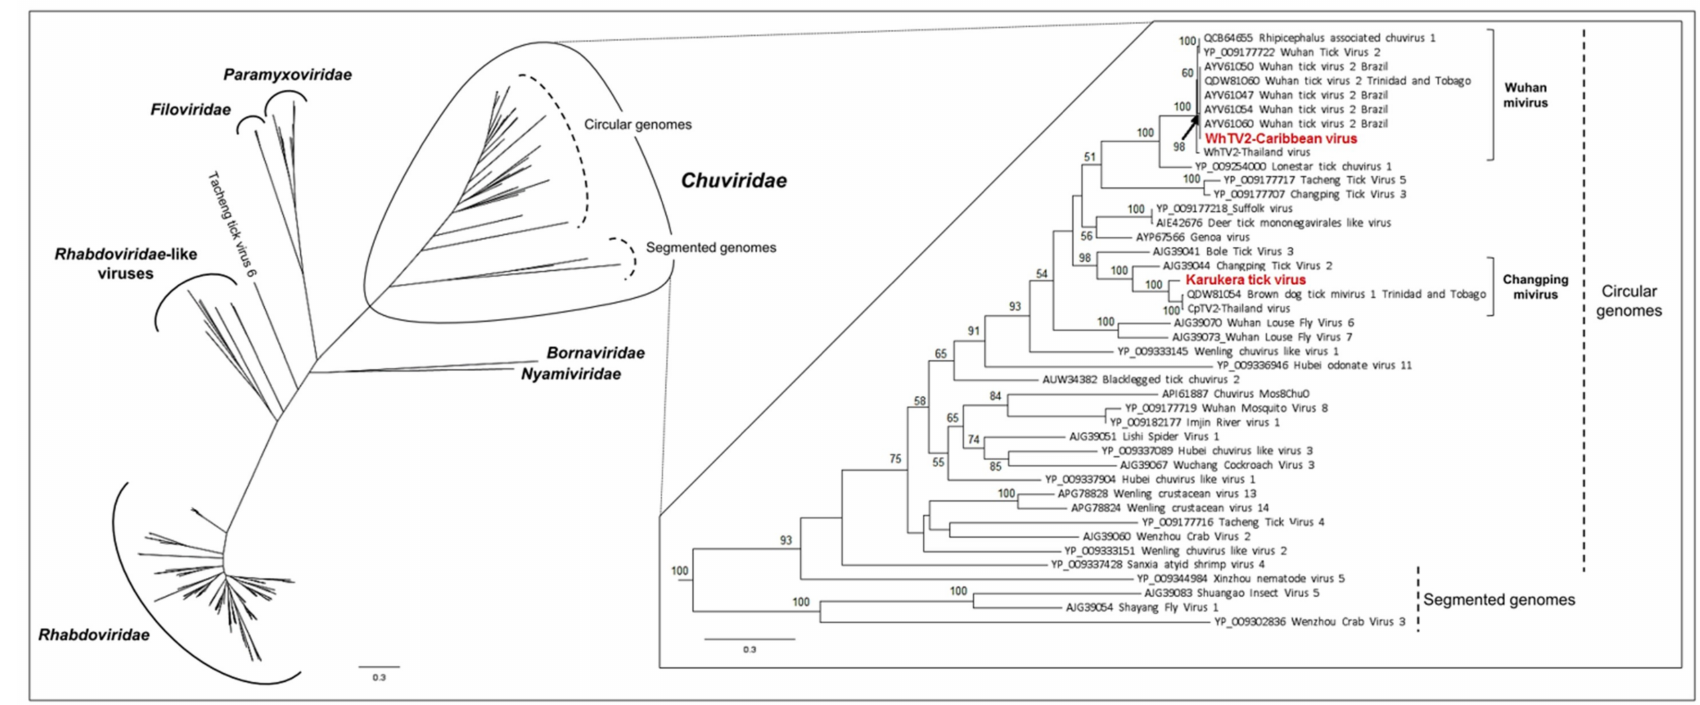
Figure 2. Phylogenetic relationship of Jingchuvirales -related viral genomes identified in Caribbean ticks (in red) with other representative viruses from the Mononegavirales and Jingchuvirales orders ( N = 169 reference sequences). Nodes with bootstrap values greater than 50 are noted. Phylogenetic reconstruction was performed by Maximum Likelihood on the complete RdRP amino-acid gene (model: LG + G + I +